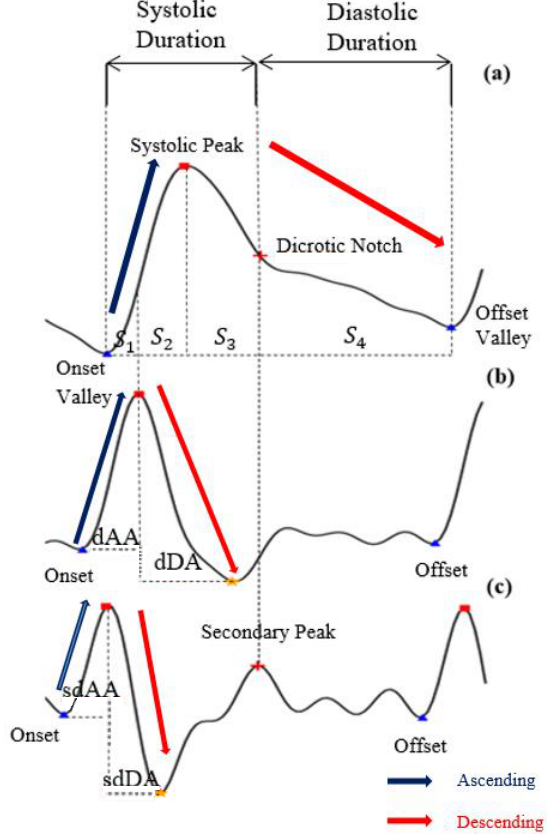
Figure 4. The results of feature point detection; ( a ) Photoplethysmogram (PPG), ( b ) 1st derivative of PPG (dPPG) and ( c ) 2nd derivative of PPG (sdPPG).